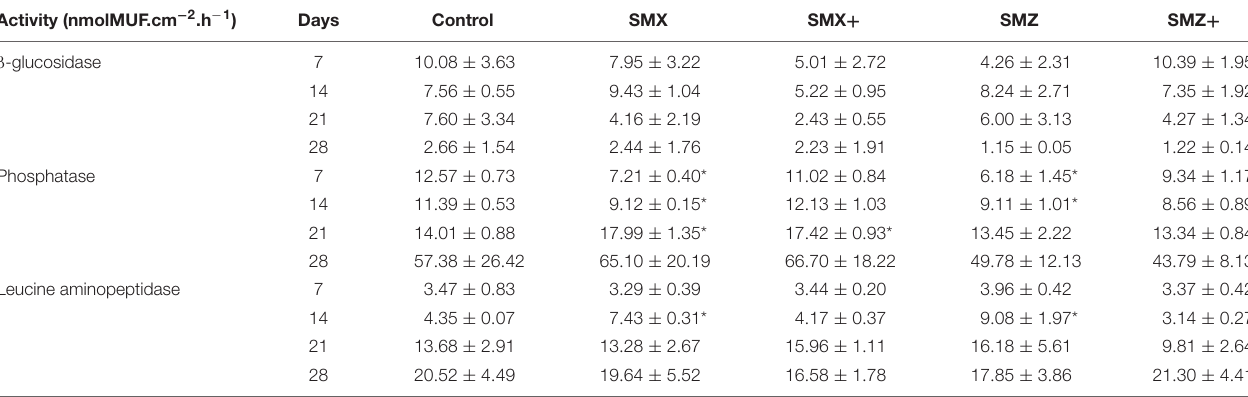
TABLE 2 | Phosphatase and leucine aminopeptidase activities (nmol MUF cm − 2 h − 1 ) of microbial communities non-exposed (control) and exposed to 500 or 5,000 ng L − 1 of sulfamethoxazole (SMX) or sulfamethazine (SMZ) over time. Activity (nmolMUF.cm − 2 .h − 1 )